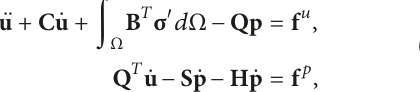
Figure 3: Shear stress-strain curve of soft